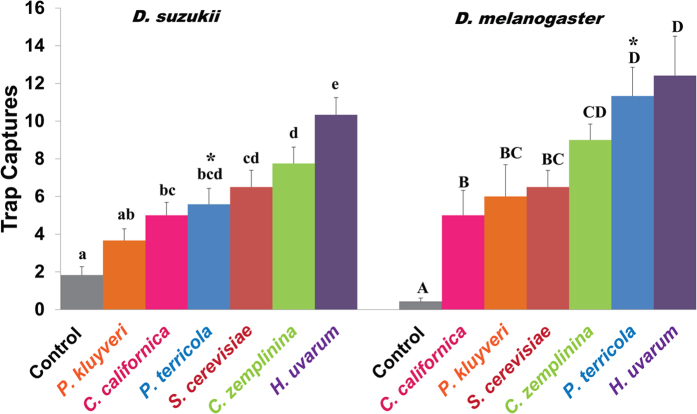
D. suzukii and D. melanogaster differentially discriminate between six yeast species based on the odors.Relative yeast preference was evaluated by simultaneously exposing flies in an arena to six traps baited with a different yeast species (represented by different colors) or PDB as control. Separate trials were carried out for each fly species with N = 12. Error bars are standard error of the means. Letters above indicate the statistical significance (p < 0.05; one-way ANOVA) within a fly species (indicated by small or capital letters). When preference between the two fly species for a given yeast was compared by an unpaired student’s t-test, the responses were not significantly different (p > 0.05) except for P. terricola (indicated by an asterisk).